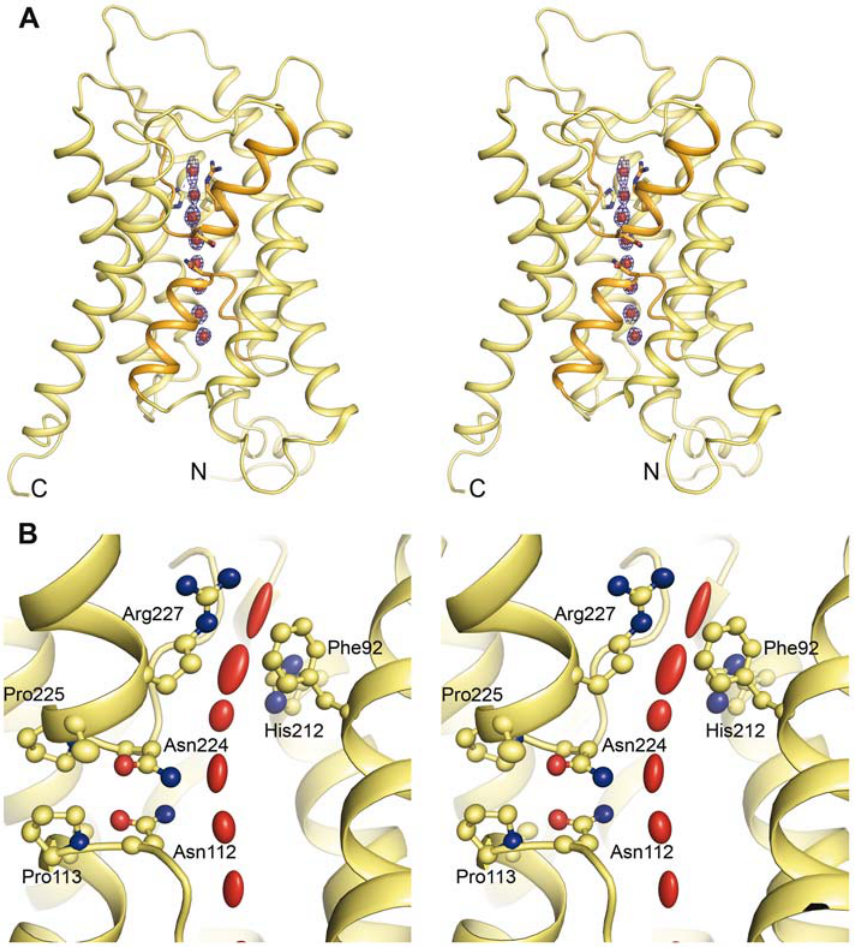
Figure 1. X-ray structure of Aqy1 at 1.15 A˚ resolution. (A) Stereo-view of a ribbon representation of the Aqy1 pore profile showing the overall structure. The two half-helices of loops B and E, which contain the aquaporin NPA signature motif, are highlighted in orange. (B) Stereo-view of ellipsoid representation of the anisotropic motions. Several water molecules are present within the channel (red) and have variable anisotropy. Carbon atoms are shown in yellow, nitrogen atoms in blue, and oxygen atoms in red.